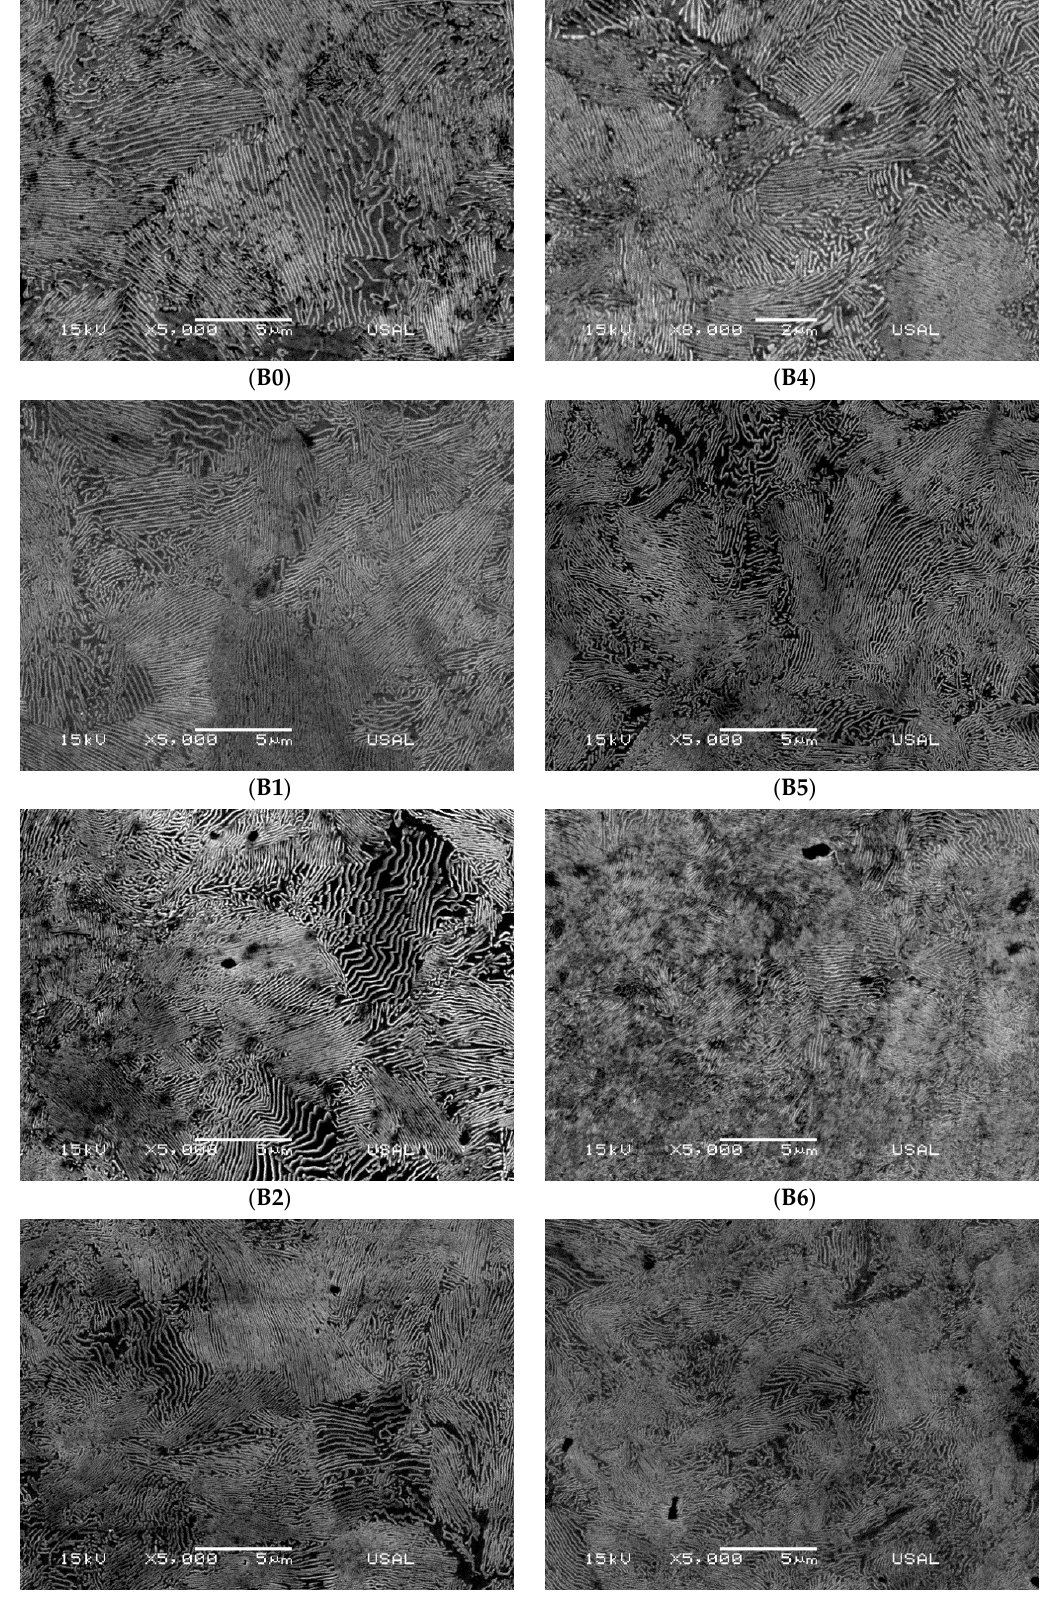
Figure 3. Metallographic analysis of the transverse section of family B for diverse drawing steps.